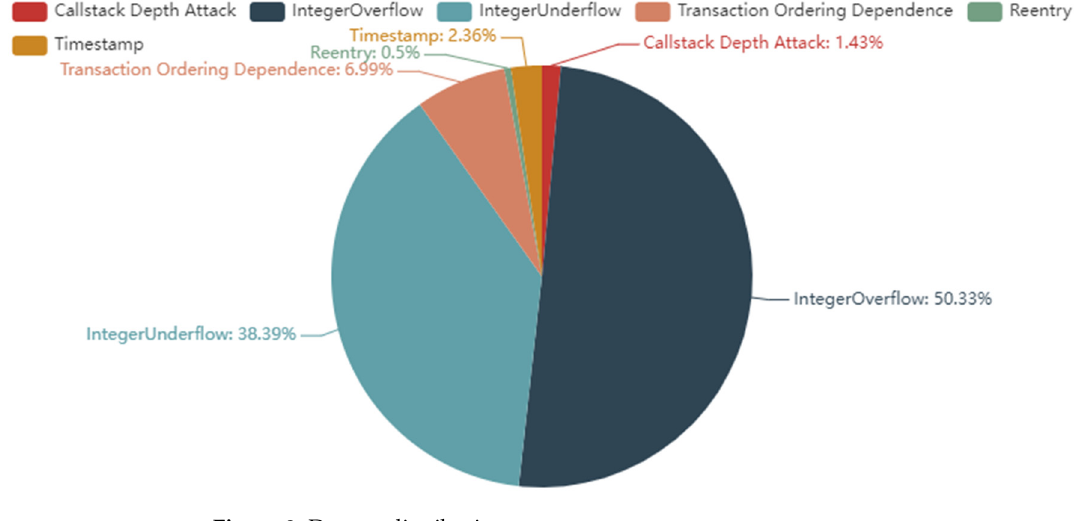
Figure 8. Dataset distribution.